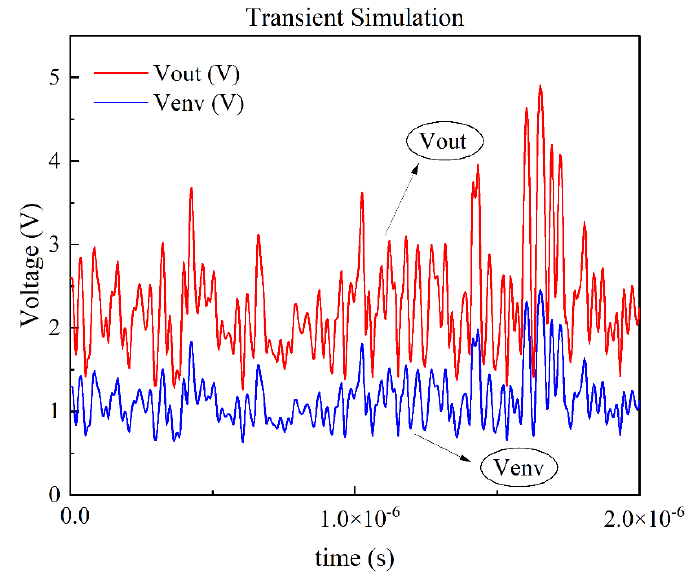
Figure 7. The transient simulation result of the LA.